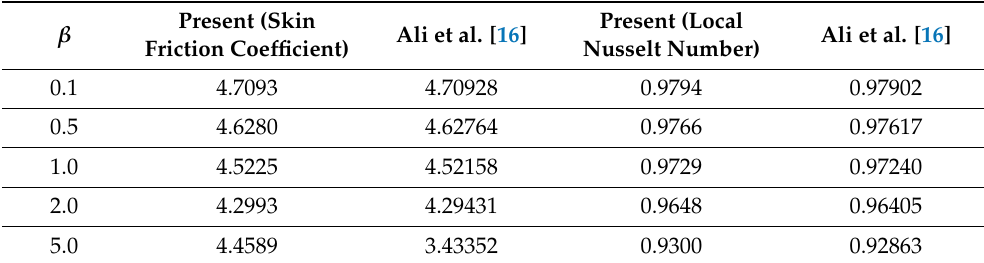
Table 3. Skin Friction coefficient and the Local Nusselt number for diverse β when p = 1.0, λ = N = 0.0, γ = 1.0, and p r = 0.72, δ = 3.0, ξ = 0.0.